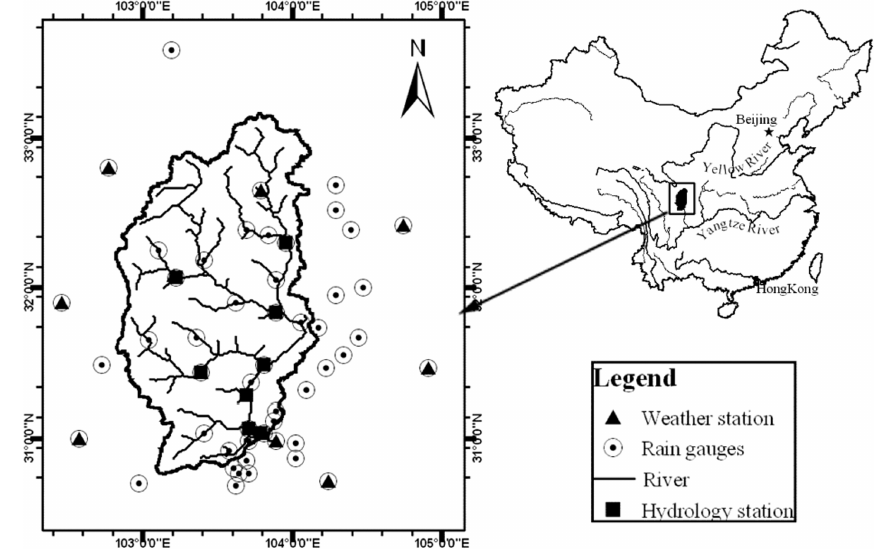
Fig. 1. Location of the Minjiang River watershed and distribution of climate and hydrometric stations (cited from Sun et al., 2008).